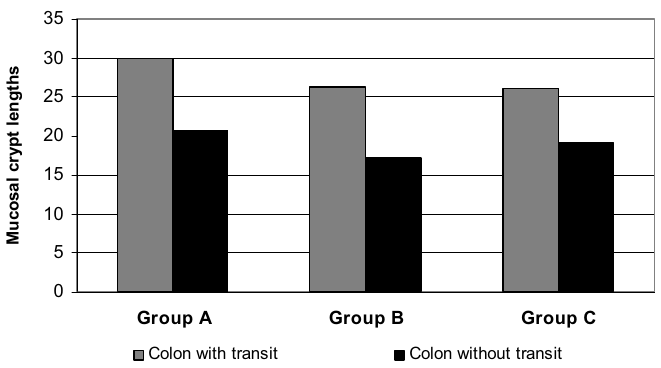
FIGURE 1 - Measurements obtained from computerized morphometry on the colon mucosal crypt lengths, in the segments with and without intestinal transit in the experimental groups. Data is present as mean of micrometers. Student t test: p< 0.0001 for all